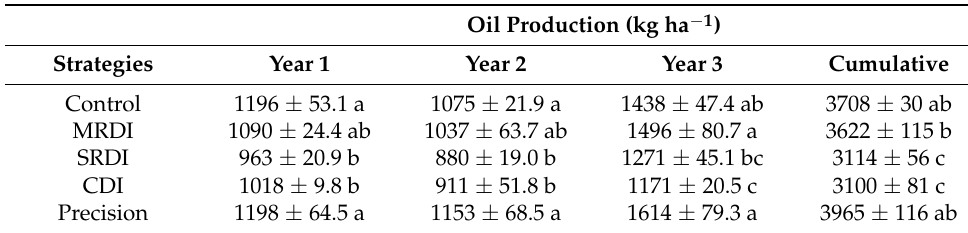
Table 8. Olive oil production (kg ha − 1 ) for the different irrigation strategies in the three years of experience and cumulative production. Different letters indicate significant differences ( p ≤ 0.05) among treatments according to Duncan’s test.